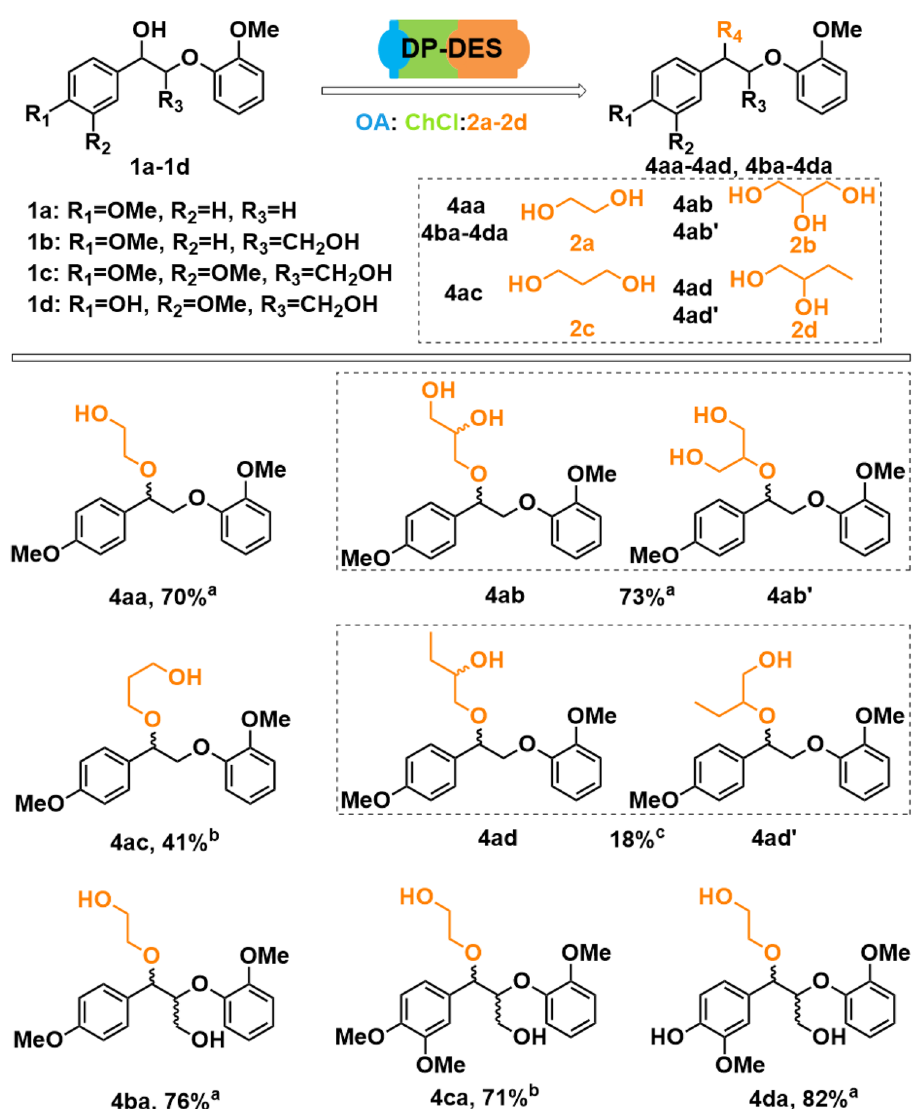
Fig. 4 Reaction scope of diol protection protocol using ternary DP-DES systems. The incorporation of various diols (glycerol, 2b ; 1,3 propanediol, 2c ; 1,2 butanediol, 2d ) into β -O-4 lignin model compound 1a or incorporation of ethylene glycol ( 2a ) into various lignin model compounds ( 1b , 1c , and 1d ) were achieved in DP-DES (30 mmol ChCl: 60 mmol diols ( 2a – 2d ): 1 wt% OA), 80 °C, 24 h, 50 mg various lignin model compounds ( 1a – 1d ) was used. a Signi fi es isolated yield, ratio of 4ab and 4ab ´ is 97:3 determined by GC-FID; b Product yield determined by GC-FID, product identi fi cation by GC/MS; c Mixture of regioisomers, not isolated, ratio not quanti fi